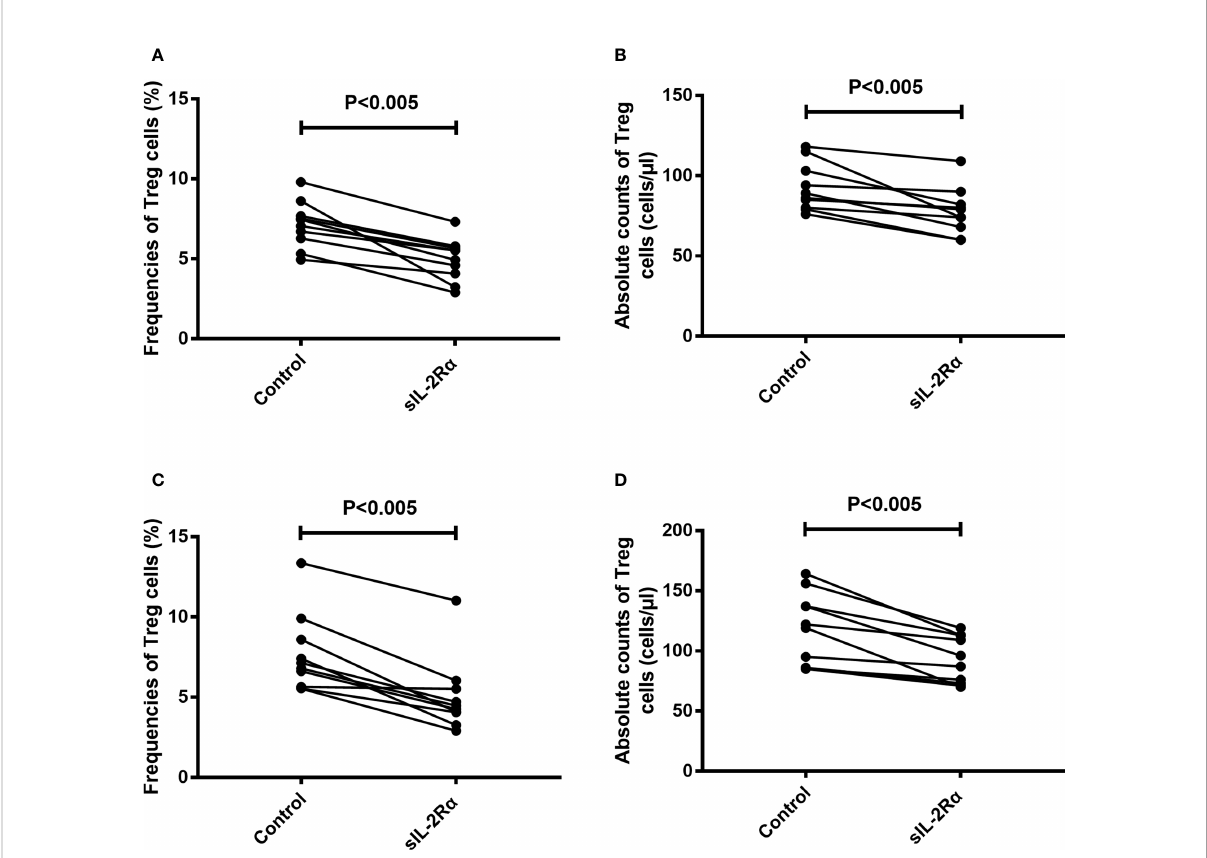
FIGURE 7 sIL-2R a suppresses the differentiation of Treg cells. (A, B) Heparin anticoagulant whole blood was collected from healthy volunteers and cultured in 37°C and 5% CO 2 for 96 h, with or without the addition of recombinant sIL-2R a at the fi nal concentration of 1000 pg/ml. (C, D) Heparin anticoagulant whole blood was collected from healthy volunteers, stimulated with PHA (10 m g/ml) and cultured in 37°C and 5%